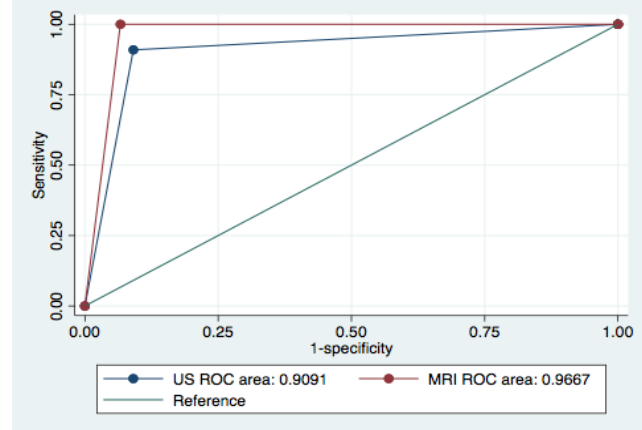
Figure 5. A 71-year-old man with intermediate-grade leiomyosarcoma of the proximal arm. US was reported as positive for recurrence due to the detection of a pseudomass/irregularity of the superfi- cial tissues of the proximal arm (circle). MRI did not show any mass. Follow-up did not show any recurrence.